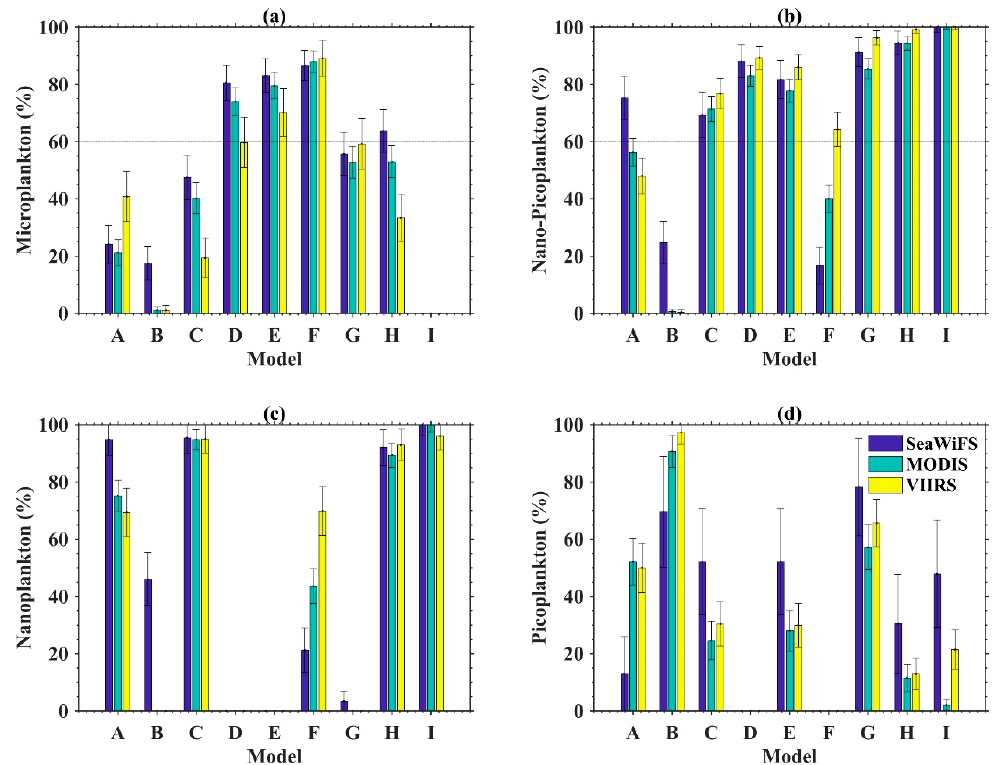
Figure 5. Performing accuracies of different models for ( a ) micro-, ( b ) mixed nano–pico, ( c ) nano-, and ( d ) pico-phytoplankton. The error bars represent the 95% confidence intervals.